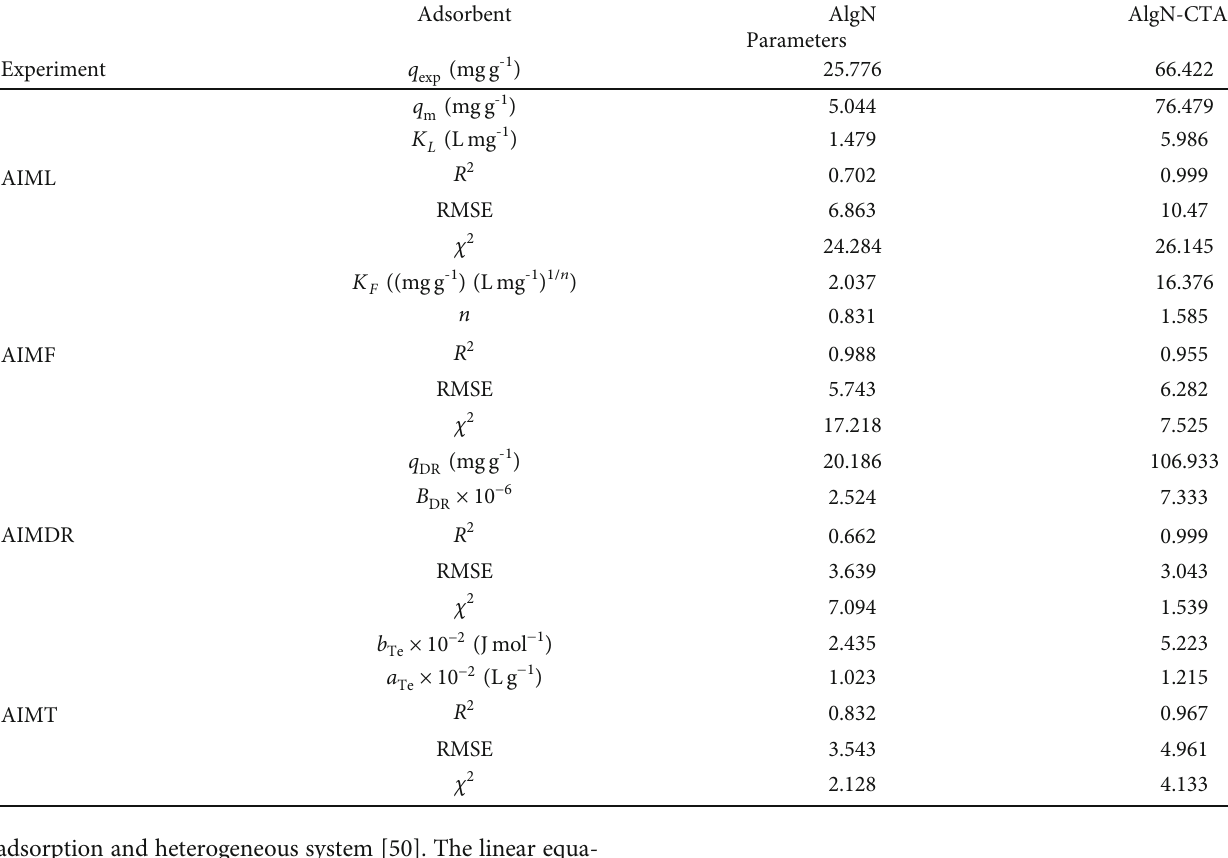
Table 3: Adsorption isotherm parameters of MO dye on AlgN and AlgN-CTAB.